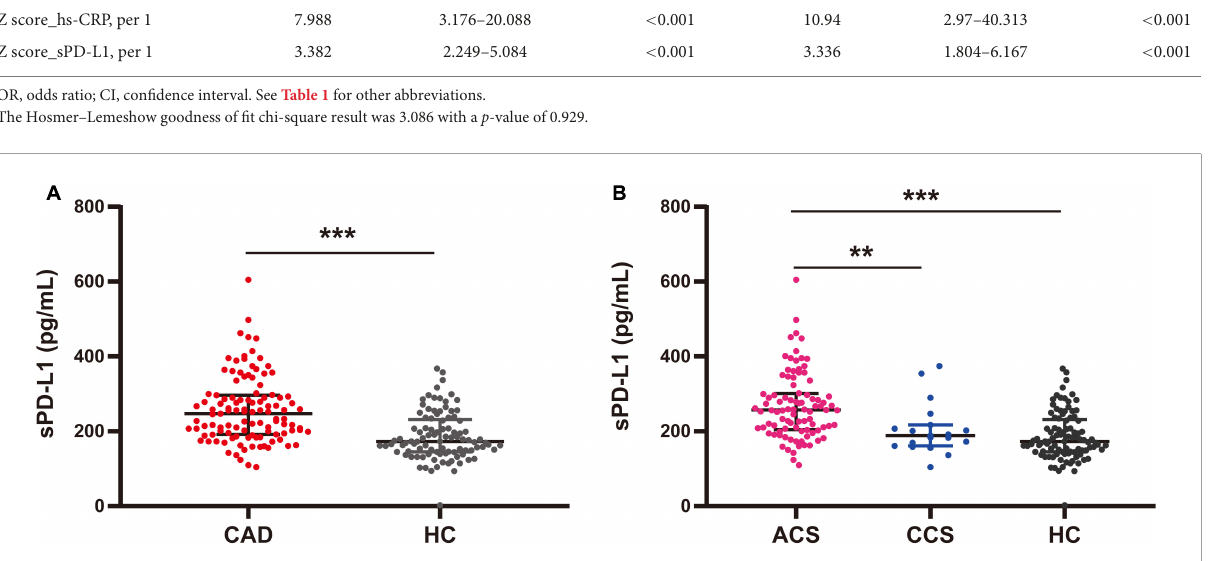
FIGURE2 Plasma levels of sPD-L1 among CAD, ACS, and CCS patients and HCs. (A) Comparison of sPD-L1 levels between CAD patients ( n = 111) and HCs ( n = 97). (B) Comparison of sPD-L1 levels among ACS patients ( n = 92), CCS patients ( n = 19), and HCs ( n = 97). There was no age difference between the groups. ** p < 0.01; *** p < 0.001. sPD-L1, soluble form of programmed cell death ligand-1; CAD, coronary artery disease; ACS, acute coronary syndrome; CCS, chronic coronary syndrome; HCs, healthy